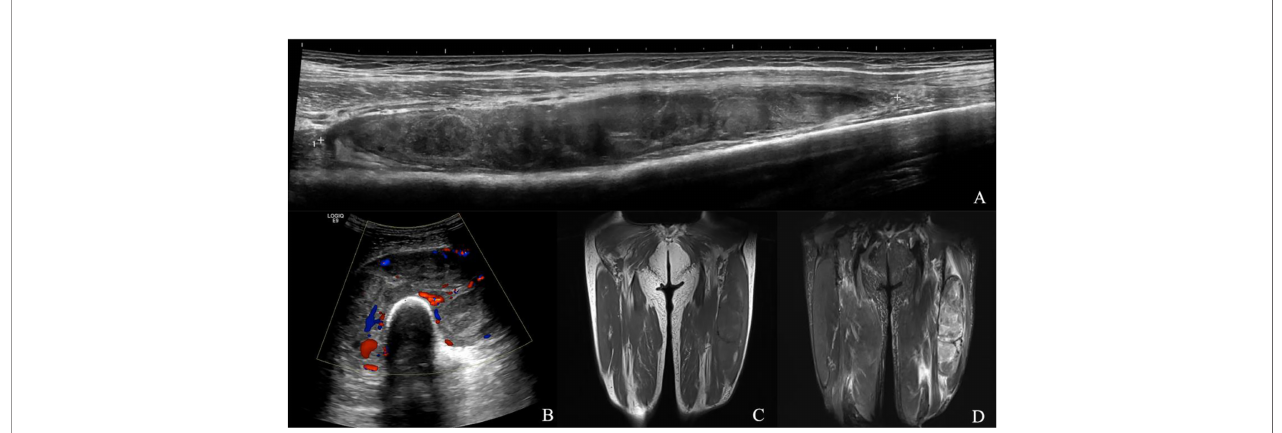
FIGURE 5 | Myxo fi brosarcoma of lower extremity. A 68-year-old male presented with a swelling in his left lower leg. (A) Longitudinal grayscale US showed a well- de fi ned, partial unsmooth, heterogenous intramuscular mass with a maximum diameter of 201 mm in the intermediate vastus muscle. (B) Color Doppler imaging of the same area showed hypervascularity within the tumor, corresponding to type IV. (C) Coronal T 1 WI showed a heterogeneous intensity mass. (D) The lesion had relatively heterogeneous high SI on the coronal fat suppressed T 2 WI with maximum diameter of 278 mm and microlobulated margin. (A, B) A score of 6 was assigned, indicating a malignant tumor (true positive). (C, D) A score of 3 was assigned, indicating a malignant tumor (true